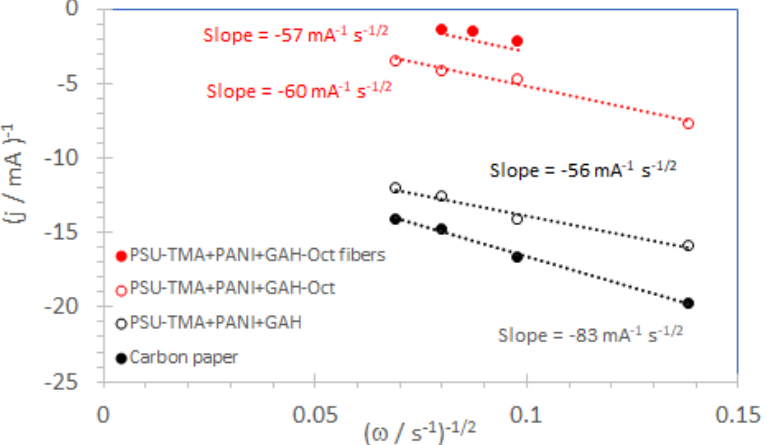
Figure 10. Koutecky–Levich plots were obtained from the LSV curves in Figure 9 and in the Supple- Figure 10. Koutecky – Levich plots were obtained from the LSV curves in Figure 9 and in the Sup- mentary Materials at − 0.5 V vs. Ag/AgCl reference electrode. plementary Materials at −0 .5 V vs. Ag/AgCl reference electrode.